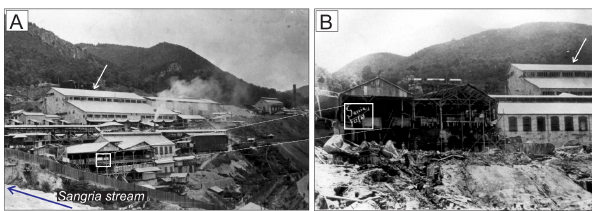
Figure 5. Aspects of Los Cedros Metallurgical plant of “Las Dos Estrellas” mining company at the Sangria stream, (a) before and (b) after the collapse. The white squares show the same location in both images, and an undisturbed roof of the Metallurgical plant (white arrows).